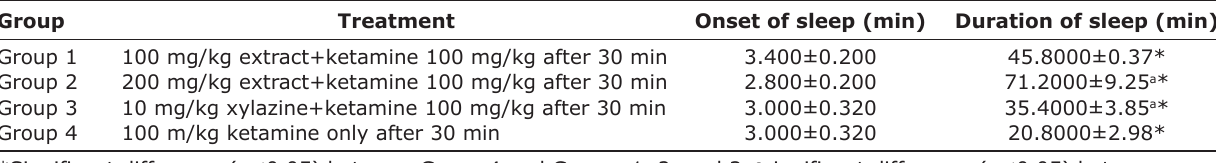
Table-2: Effect of the methanol leaf extract of Ficus exasperata on ketamine-induced sleeping time in mice. Group